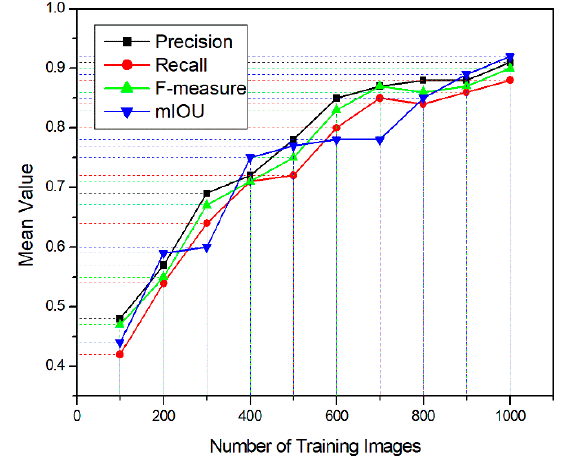
Figure 5. Detection performance for panicles in terms of average evaluation index value versus number of training images.